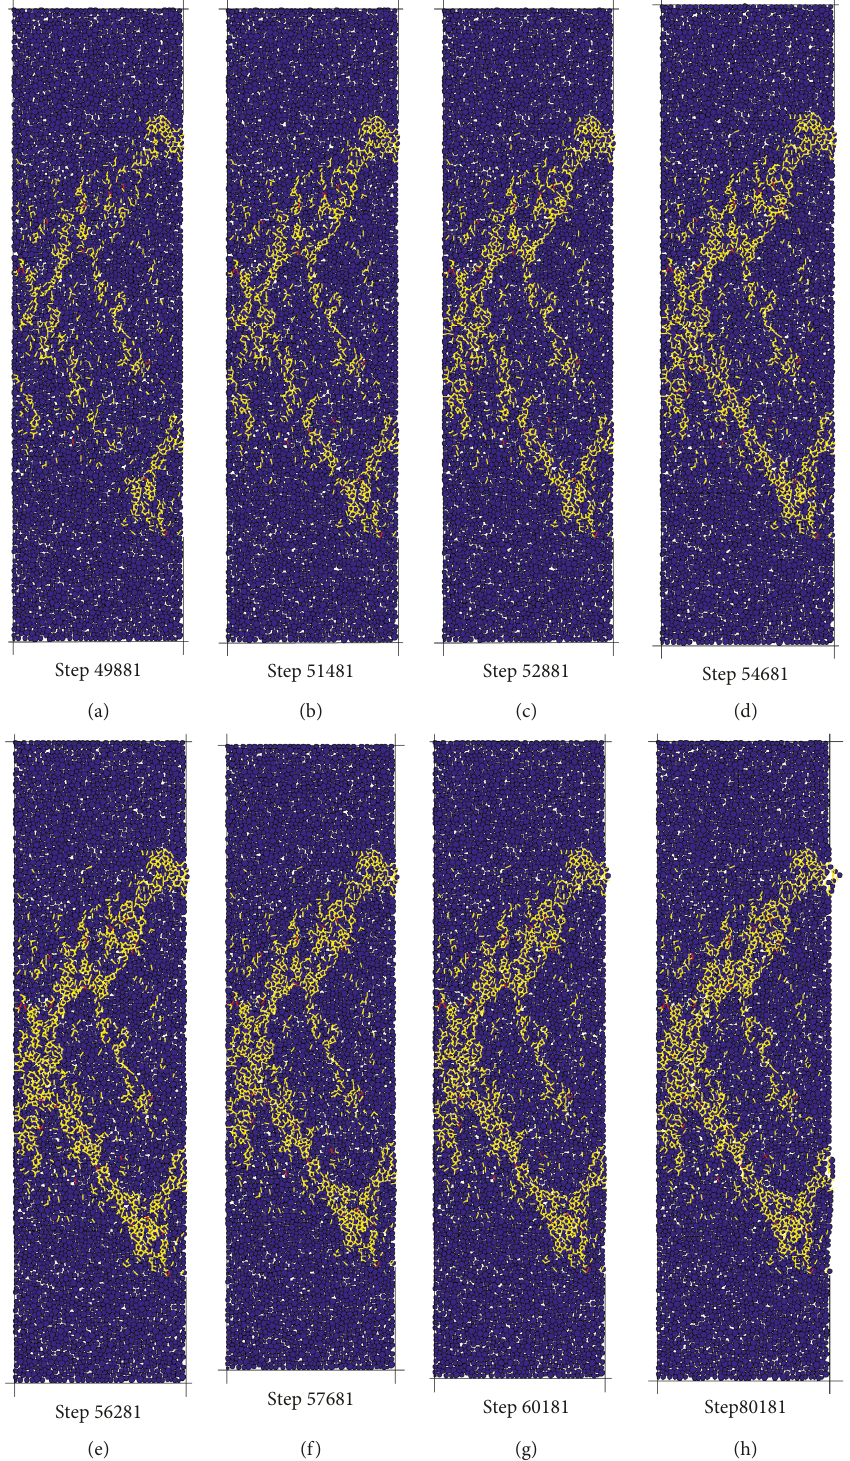
Figure 9: Failure process of # F4 strain burst test ( R � 9.8870 and R � 19.7741). (a) Step 49881. (b) Step 51481. (c) Step 52881. (d) Step 54681. E K (e) Step 56281. (f) Step 57681. (g) Step 60181. (h) Step vertical strains go down. It is observed that with lower the increasing vertical stress. With lower Young’s moduli Young’s moduli ratio and stiffness ratio, the roof and floor ratio and stiffness ratio, both the roof and floor show larger also have larger inverse vertical strains, which are applied to vertical strains. In the postpeak region, with the decreasing the failing rock and induce larger strain and more violent vertical stress, the roof and floor deform inversely and their